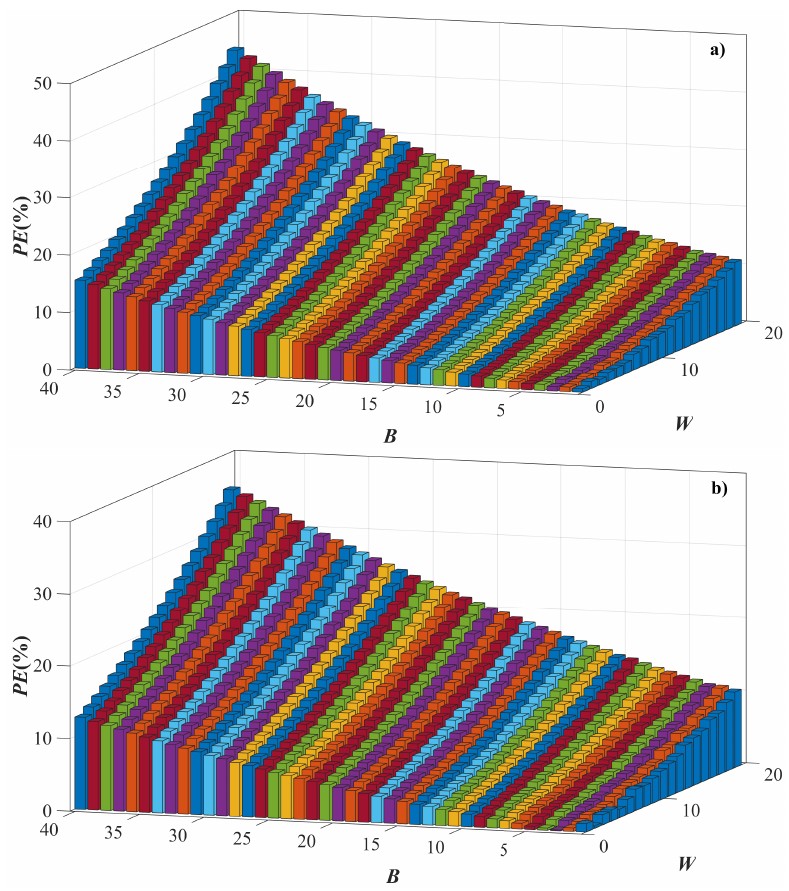
Figure 7. Impact of parameters W and B on the accuracy of Method #5. Indicative results for ( a ) G2 and ( b ) G3. Similar trend is also observed for G1. Table 2. Optimal value of K and resulting PE for Method #1, Method #2, Method #3, and Method #4. Minimum PE are highlighted with bold font.